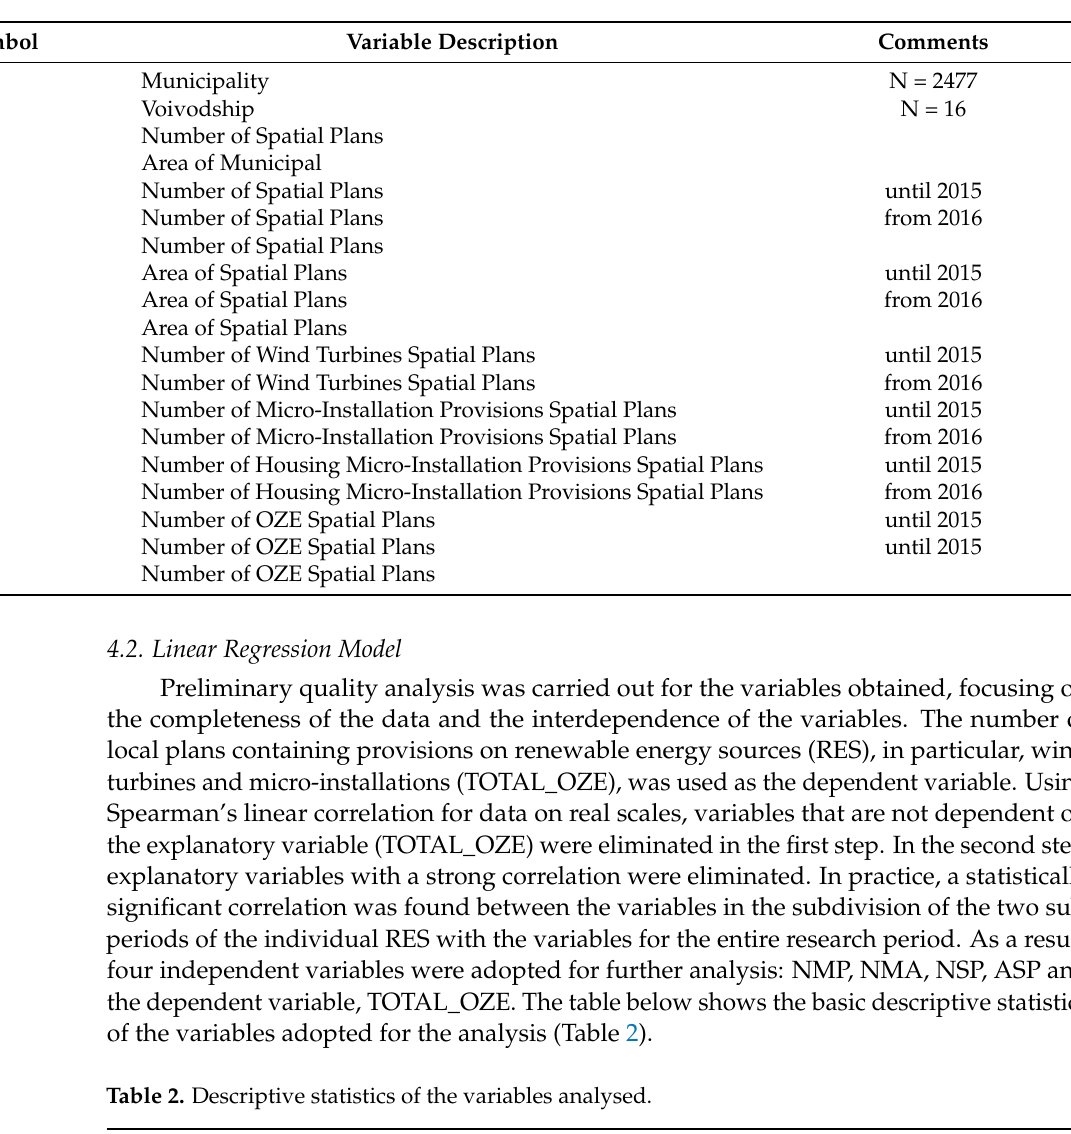
Table 1. Variables used in the study.